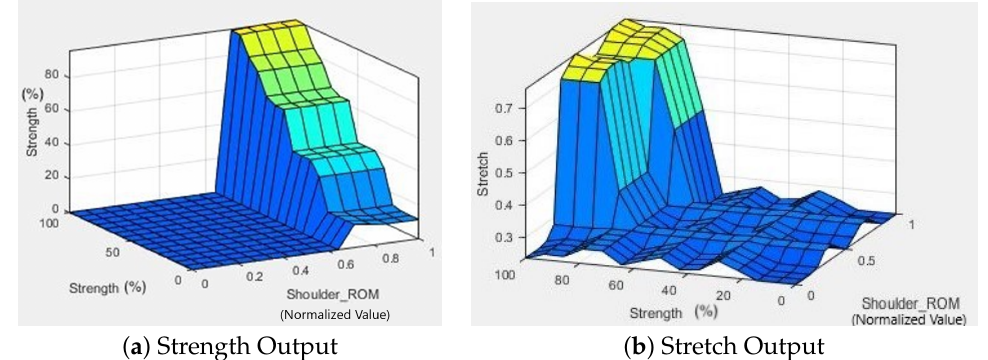
Figure 8. Surface Viewer plot of the second FIS. ( a ) Strength output plot shows that the strengthening exercises are only assigned when the input shoulder ROM (level of exercise) is higher than 0.5, which implies an advanced range, while the intensity of strengthening exercise (output) rises steadily with increased input strength. ( b ) Stretch output plot shows that a high shoulder ROM, i.e., level of exercise > 0.5, with high input strength results in “Hard Stretching” output, represented by a value greater than 0.5, and for lower ROM and strength, “Easy Stretching” output, represented by a value less than